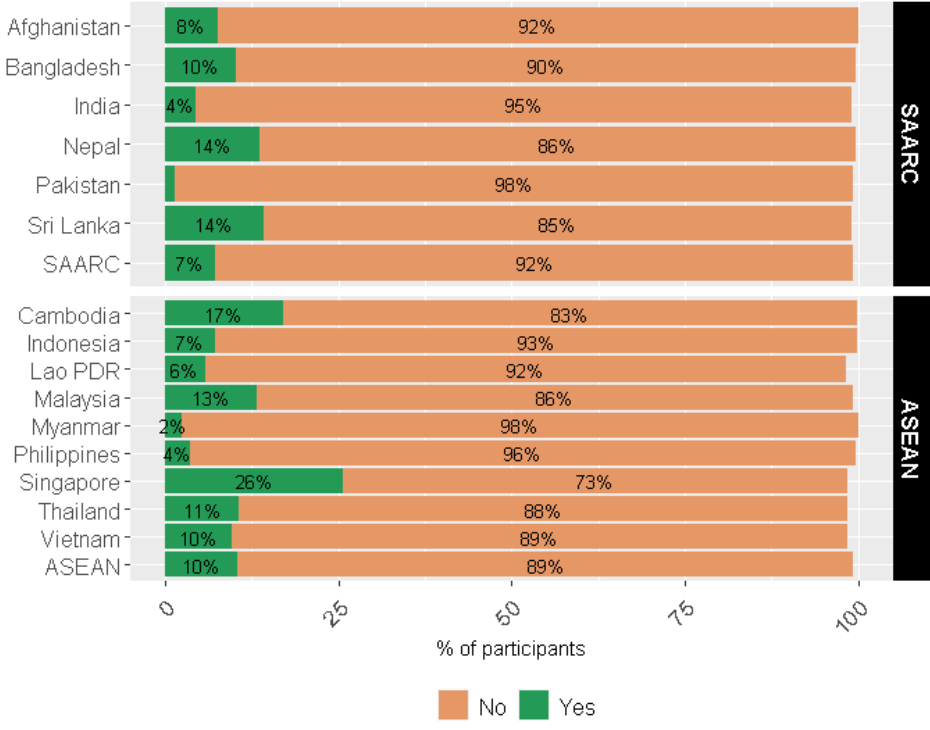
Figure 9. Percentage of participants who borrowed money for purchasing property or land.